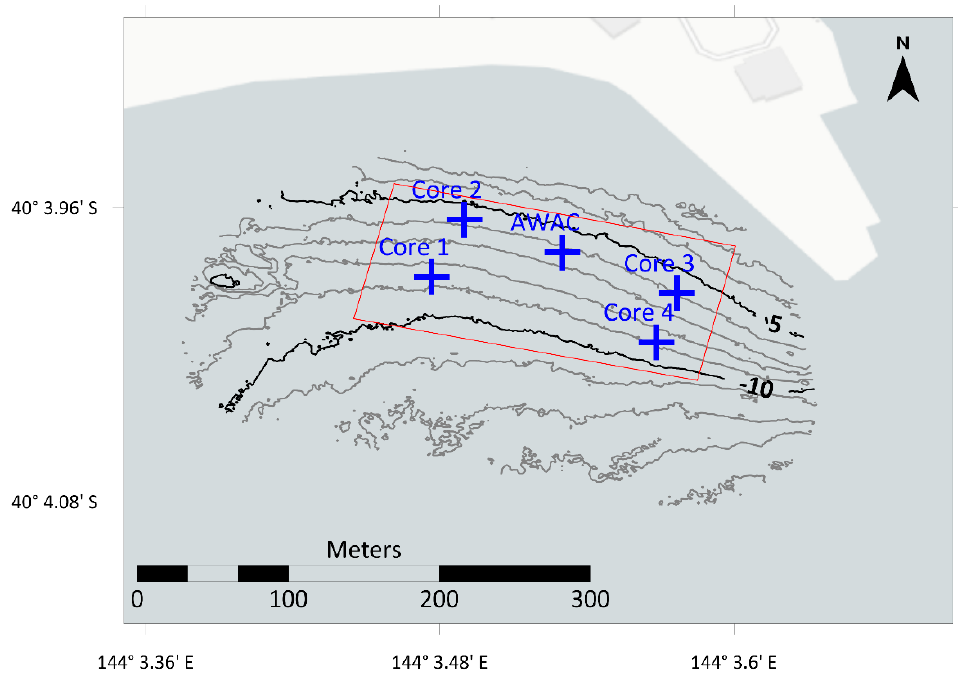
Figure 3. Bathymetry of the candidate site (boundaries depicted by the red rectangle) overlaid with core locations. Blue crosses depict five cores at each site, i.e., the center locations and four cores taken 10 m away from the center in the cardinal directions.